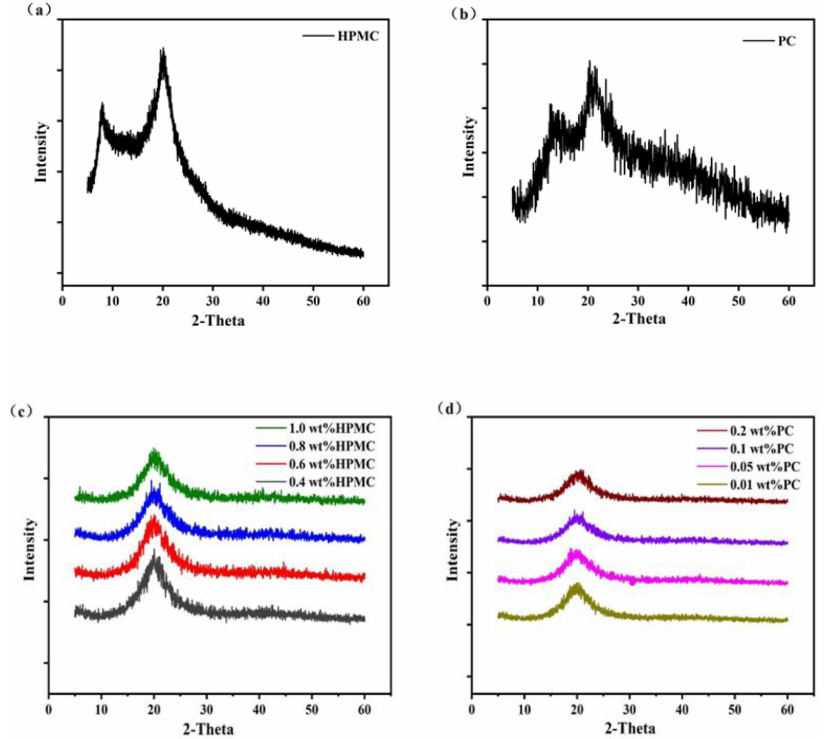
Figure 8. XRD patterns of HPMC powder ( a ), PC powder ( b ). XRD patterns of oleogels prepared by different HPMC concentrations and a constant PC concentration (0.1 wt%) ( c ). XRD patterns of oleogels prepared by different PC concentrations and a constant HPMC concentration (0.8 wt%) ( d ). (HPMC—Hydroxypropyl methylcellulose,